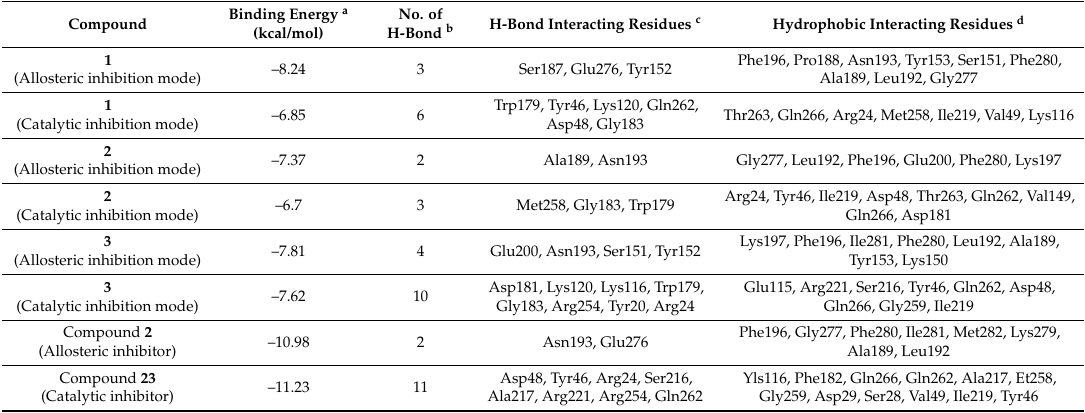
Table 2. Molecular interaction of the protein tyrosine phosphatase 1B (PTP1B) active site with 1 – 3 as well as reference